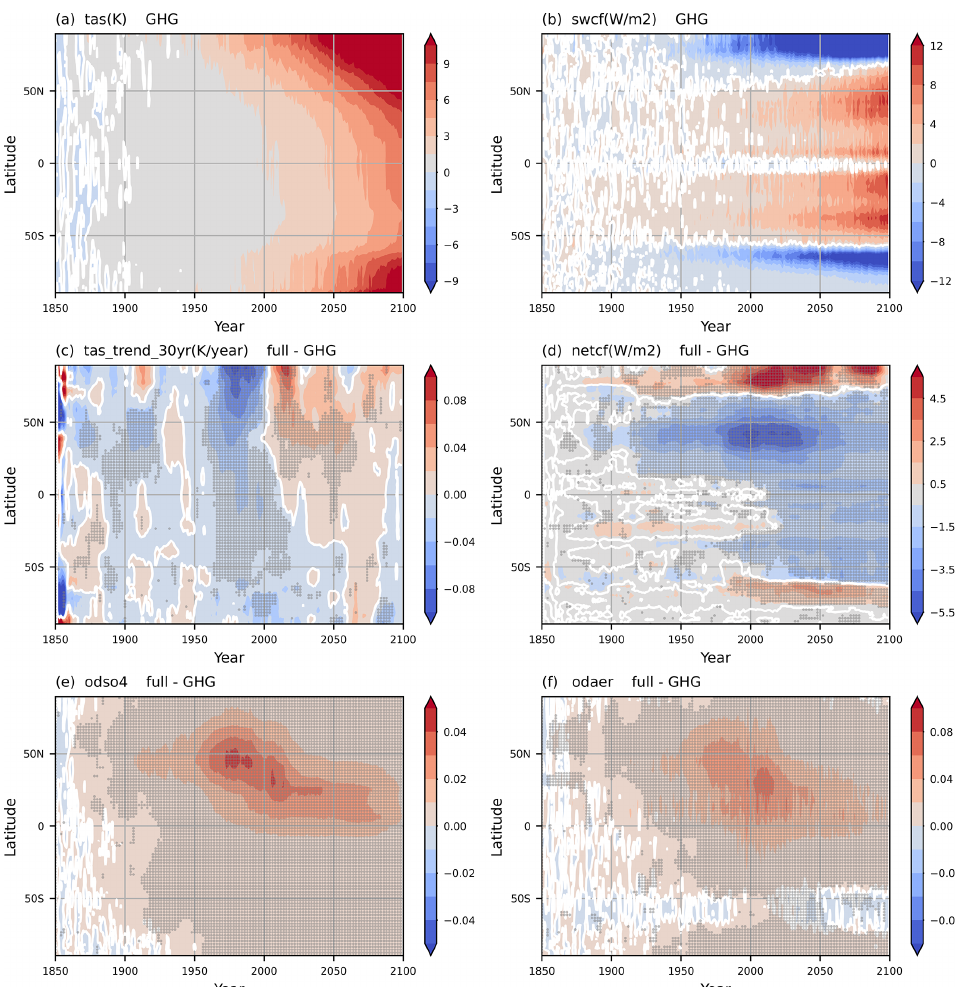
Figure 15. The time evolution of the zonal mean local (a) T air change (K), (b) SW cloud radiative forcing (Wm − 2 ) in E3SMv1.0 GHG- only simulations, and the simulated differences in (c) T air trend (Kyr − 1 ), (d) net cloud radiative forcing (Wm − 2 ), (e) sulfate aerosol optical depth at 550nm, and (f) total aerosol optical depth at 550nm between E3SMv1.0 all-forcing simulations and GHG-only simulations. Stippled regions in panels (a) – (c) indicate where the difference reaches the 95% confidence level based on a two-tailed Student’s t